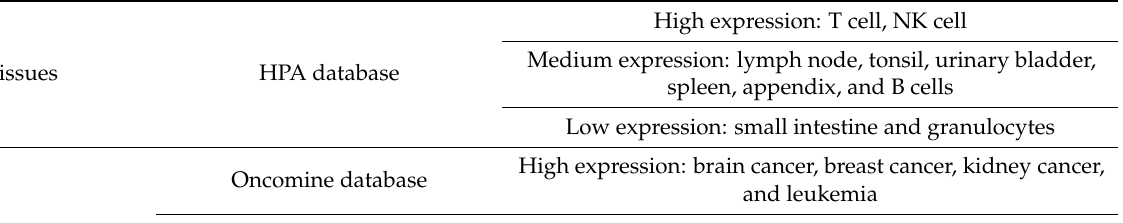
Table 1. Expression of CD96 in normal tissues and